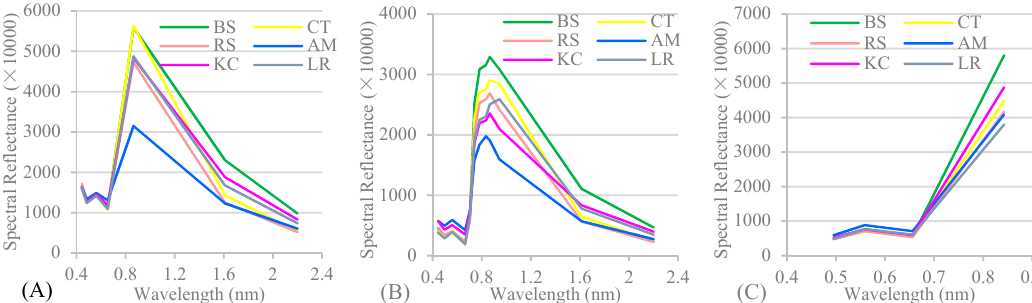
Figure A3. The spectral reflectance of six mangroves species in ( A ). Landsat 8, ( B ). Sentinel-2 and ( C ).